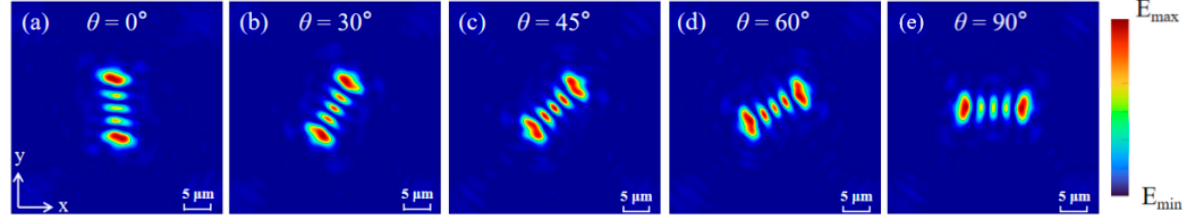
Figure 6. The optical field distribution of the focused vortex beam under the rotation angle θ based on LOCP, where ( a ) corresponds to θ = 0°, ( b ) corresponds to θ = 30°, ( c ) corresponds to θ = 45°, ( d ) corresponds to θ = 60°, and ( e ) corresponds to θ = 90°.